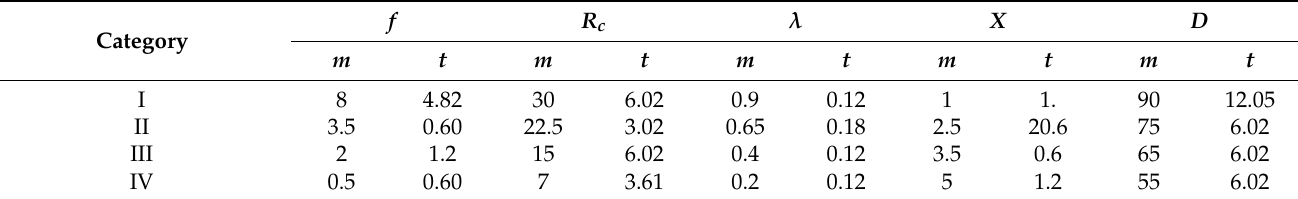
Table 3. Related parameters in membership